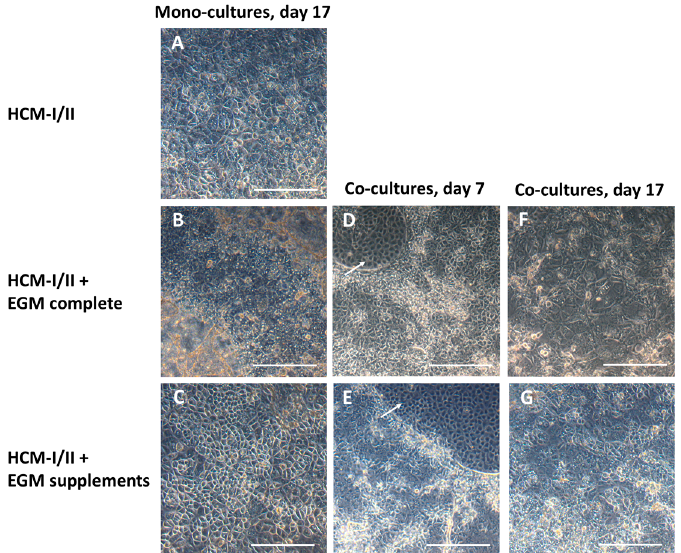
Figure 4. Morphology of human induced pluripotent stem cells (hiPSC) after hepatic differentiation over 17 days in different media and/or in co-culture with human umbilical vein endothelial cells (HUVEC). The pictures show hiPSC after hepatic differentiation in mono-culture over 17 days in hepatocyte culture medium (HCM-I/II) ( A ), in a 1:1 mixture of hepatocyte culture medium and endothelial cell growth medium EGM, consisting of basal medium and supplements (HCM-I/II + EGM complete) ( B ) or in HCM enriched with EGM supplements (HCM-I/II + EGM supplements) ( C ); hiPSC after hepatic differentiation in co-culture with HUVEC on day 7 of differentiation using HCM-I/II + EGM complete ( D ) or HCM-I/II + EGM supplements ( E ); hiPSC after hepatic differentiation in co-culture with HUVEC on day 17 of differentiation using HCM-I/II + EGM complete ( F ) or HCM-I/II + EGM supplements ( G ). HUVEC were growing in free spaces between the hiPSC (arrows). Scale bars correspond to 300 µm.